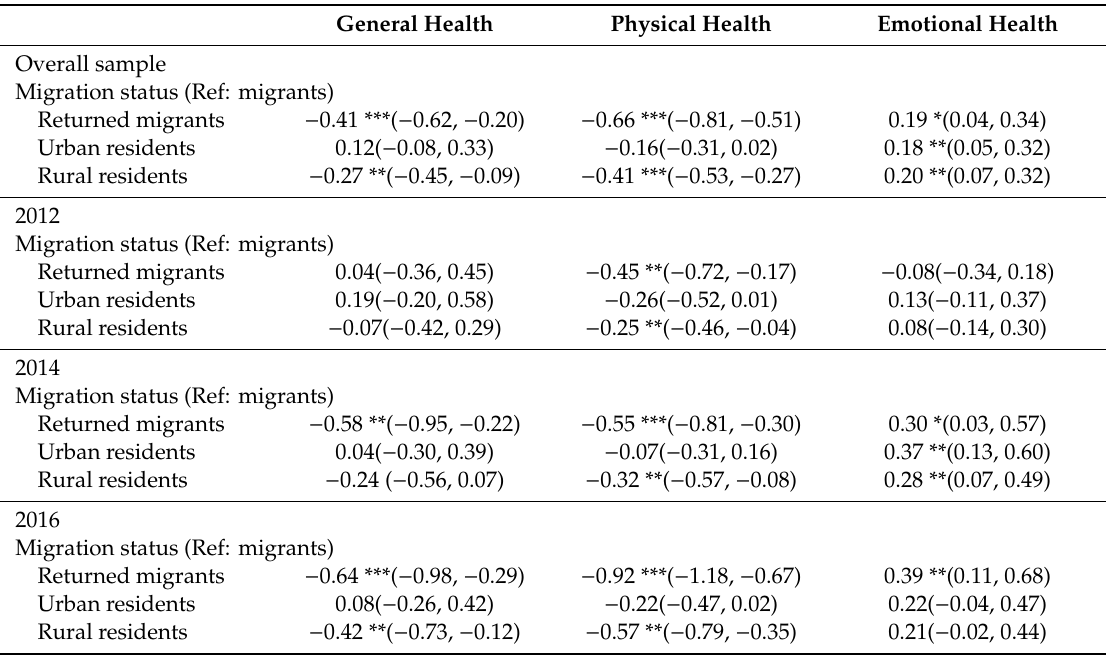
Table 2. Marginal e ff ects of migration status (comparing with migrants).